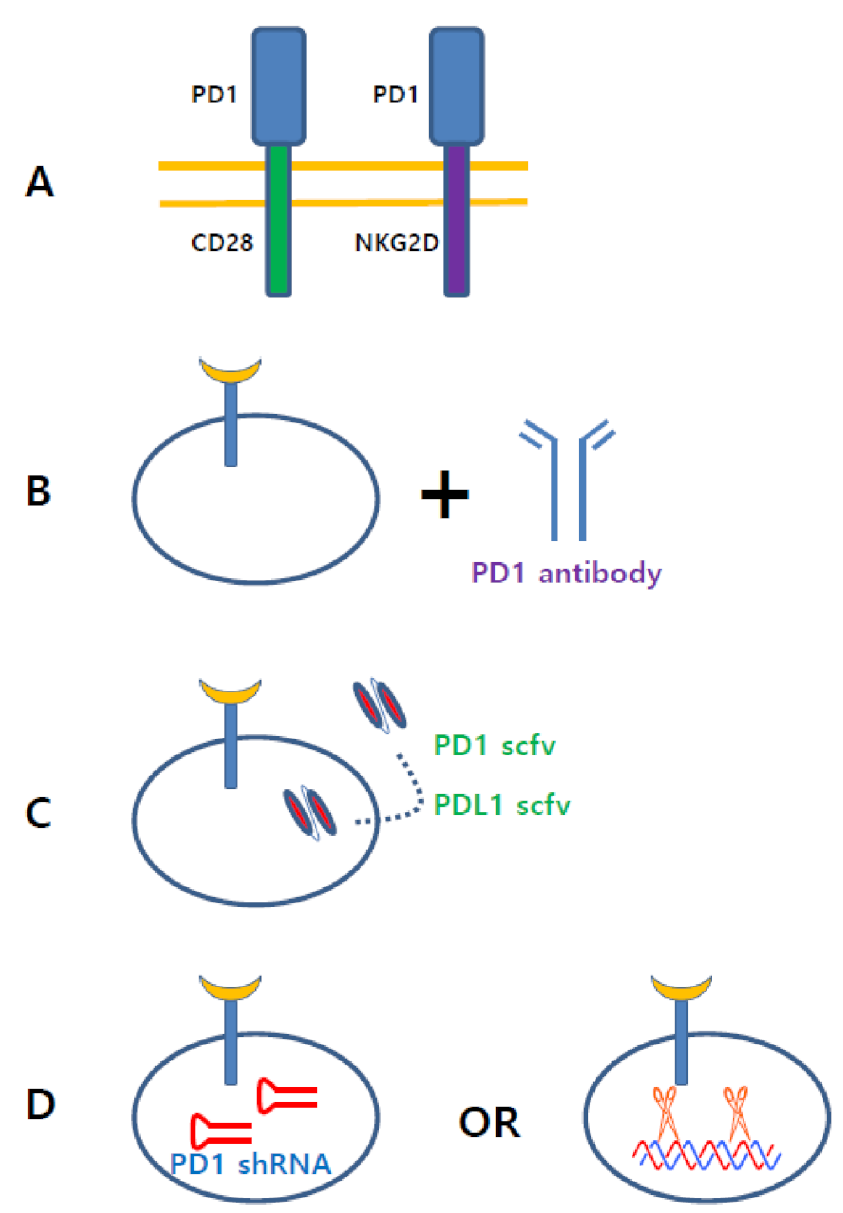
Figure 4. Various approaches targeting PD1 signaling in CAR T cell. ( A ). Decoy receptors, composed of PD1 extracellular domain fused with CD28 or NKG2D endodomain, convert immune inhibitory signal to immune activating signal. ( B ). CAR T cell therapy combined with PD1 antibody demon- strated excellent anti-cancer effect in preclinical models. ( C ). CAR T cells secreting PD1 scFv or PDL1 scFv potentiates CAR T cell activity. ( D ). Depletion of PD1 protein by shRNA or CRISPR technology increased anti-cancer activity of CAR T